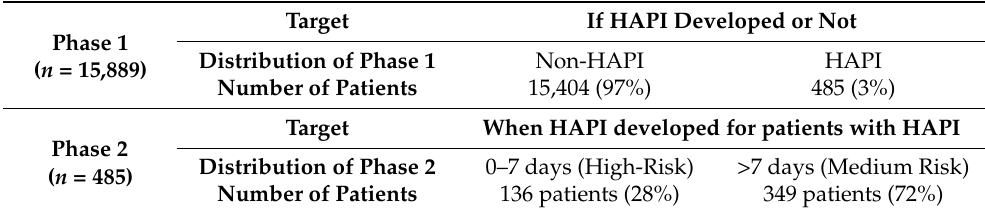
Table 1. Dataset distribution in phases 1 and